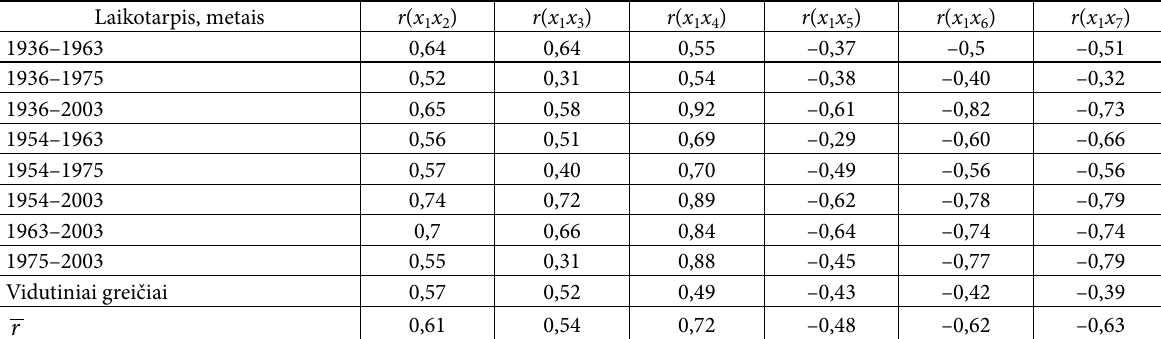
Table 1. The correlation of vertical Earth surface movement speed with geological, geomorphologic parameter Laikotarpis, metais